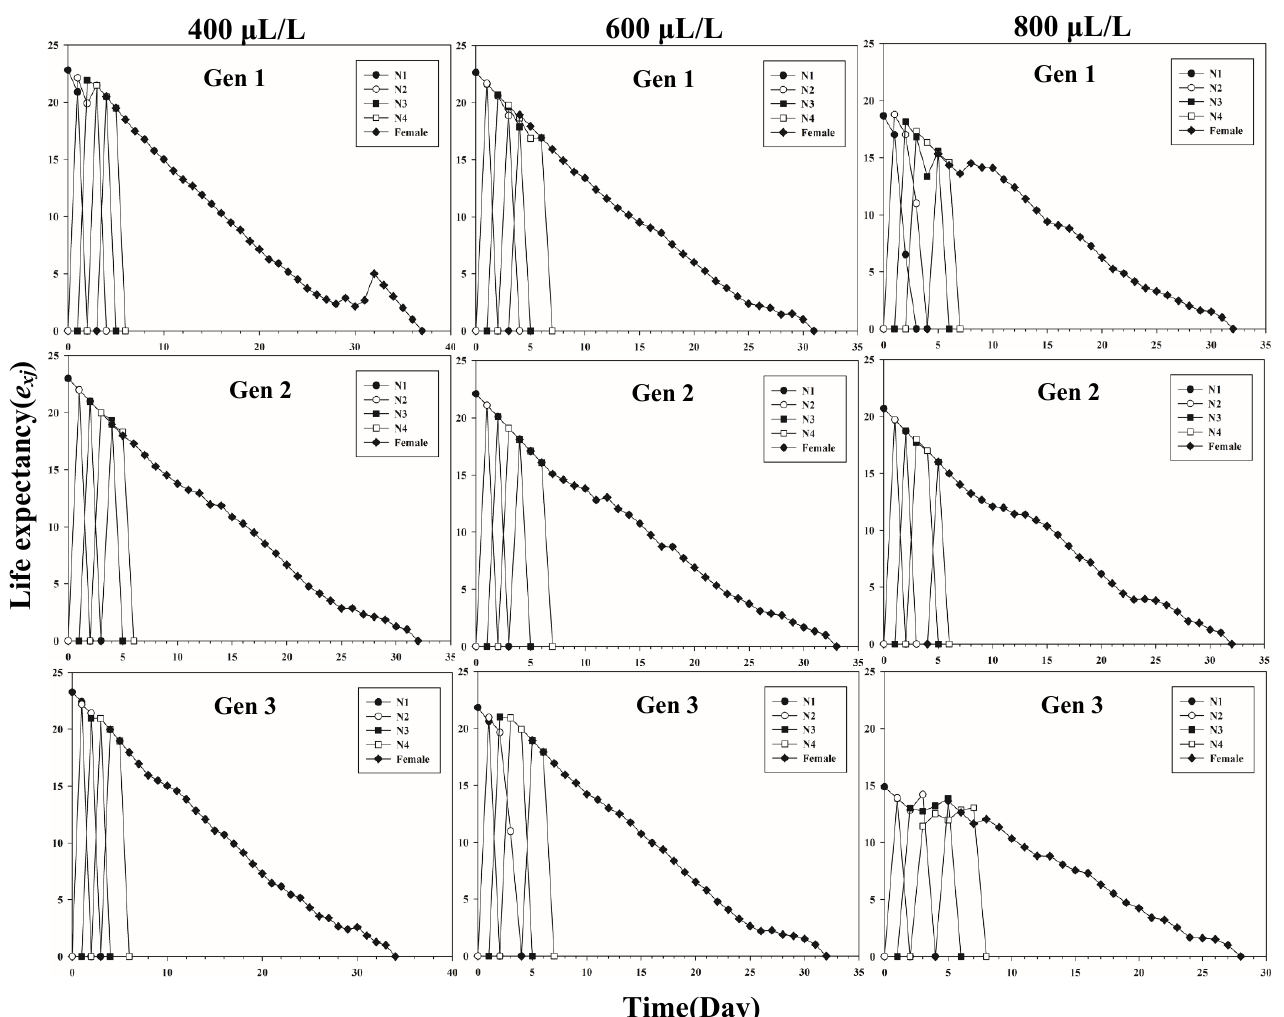
Figure 4. Age-stage-specific life expectancy ( e xj ) of three successive generations of L. erysimi under three CO 2 treatments. Table 2. Population parameters of successive three generations of L. erysimi under three CO 2 treatments (mean ± SE).